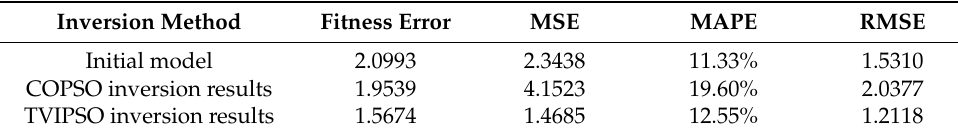
Figure 20. Comparison of the relative permittivity inversion results at various distances: ( a ) 0.3 m; ( b ) 0.5 m; ( c ) 0.7 m. Table 5. Comparison of iteration details for the two inversion algorithms.